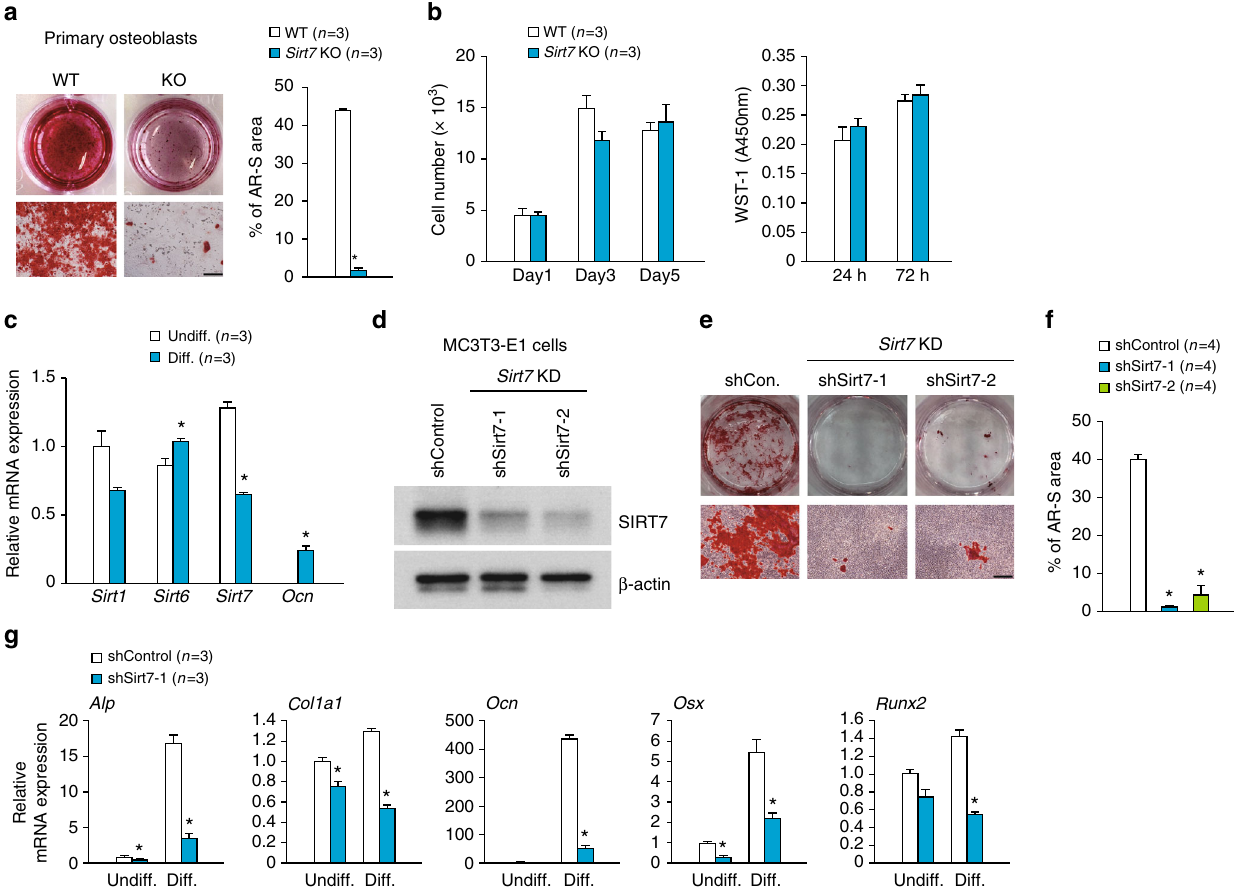
Fig. 3 SIRT7 positively regulates osteoblast differentiation. a Primary calvarial osteoblasts derived from Sirt7 KO mice and WT mice were cultured for 10 days in differentiation medium. Representative Alizarin Red S-stained images (left) and the Alizarin Red S staining area ratio (right). b Proliferation assay using primary calvarial osteoblasts from Sirt7 KO mice and WT mice. Cell proliferation was measured by direct counting (left) and by the WST-1 colorimetric assay (right). c Expression of Sirt1, Sirt6, Sirt7 , and Ocn in MC3T3-E1 cells analyzed by qRT-PCR. d – g MC3T3-E1 cells with Sirt7 knockdown and control cells were cultured for 30 days in differentiation medium. Con fi rmation of knockdown by western blotting ( d ), representative Alizarin Red S-stained images ( e ), Alizarin Red S staining area ratio ( f ), and expression of osteoblastic marker genes analyzed by qRT-PCR ( g ). Undiff.: cells cultured in